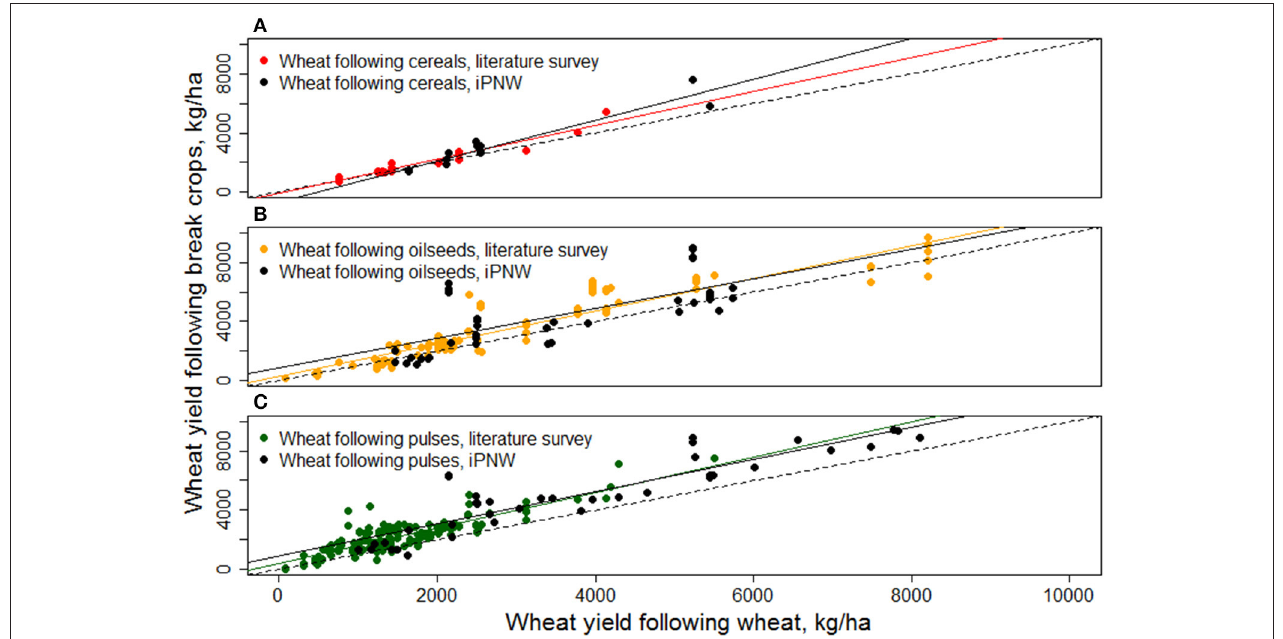
FIGURE 6 | Literature survey of wheat yields following fallow (y-axis) vs. alternative crops, including cereals (A) , oilseeds (B) , and pulses (C) (y-axis). Fallow replacement by oilseeds, pulses, and other cereals was also assessed in inland PNW.